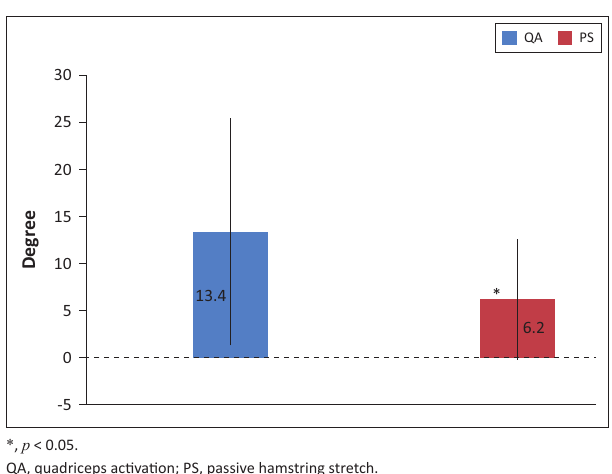
FIGURE 2: Mean improvement of hamstring muscle flexibility (in degrees) ± standard deviation between quadriceps activation and passive stretch groups.